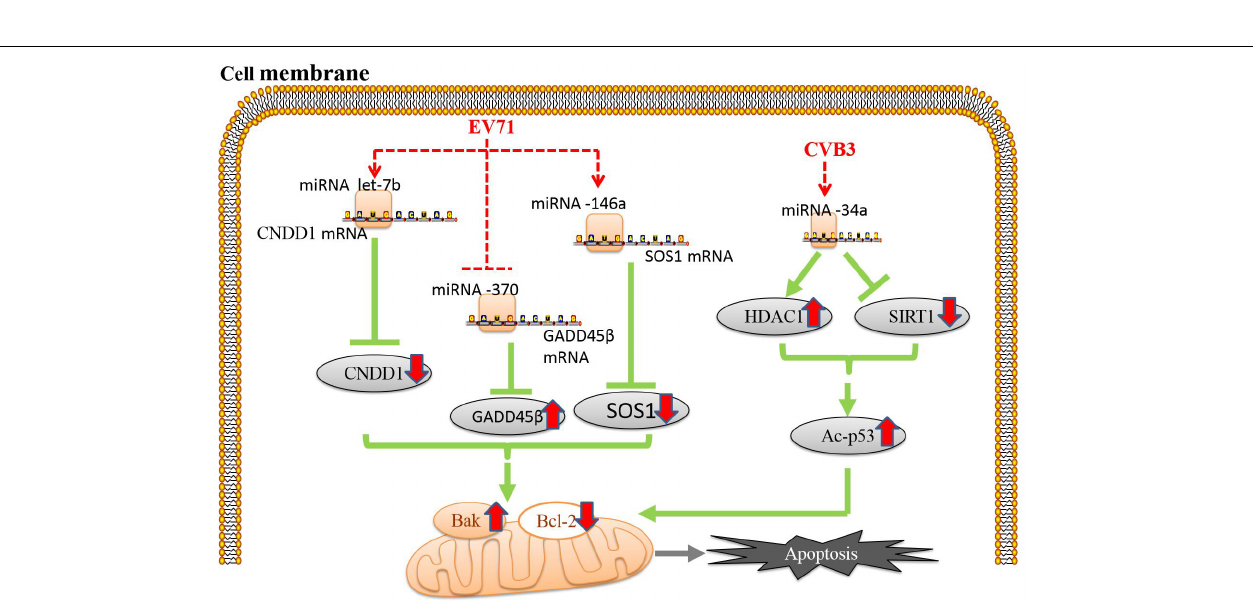
FIGURE 3 | Enteroviruses regulate miRNAs to induce apoptosis. Apoptosis induced by enterovirus infection is associated with the regulation of microRNAs (miRNAs) (Chang et al., 2015; Jiang et al., 2019). The red dotted line indicates the site of enteroviral action, and the red solid arrows indicate the up- or downregulation of the expression of each